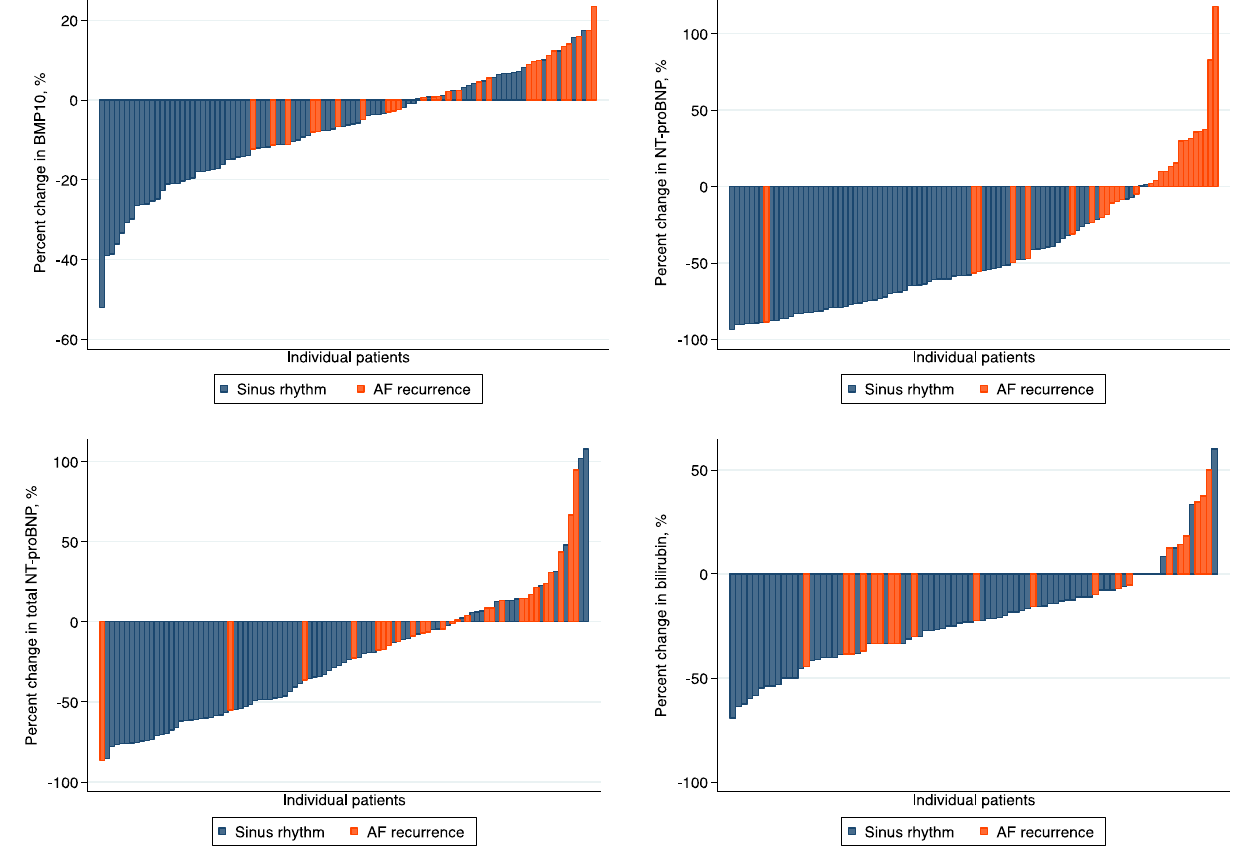
Figure 2. Waterfall plots of percent changes in biomarker levels by rhythm status after cardioversion. X-axis represents individual patients, y-axis percentage change; bars are percent change of biomarker at follow-up for each patient.